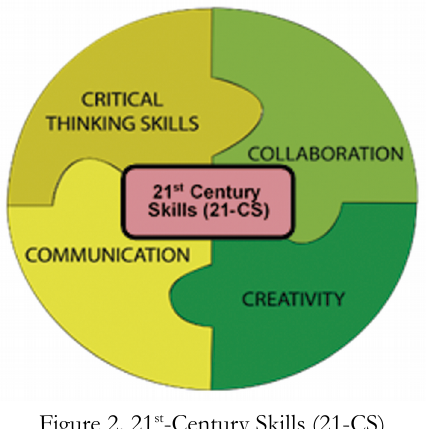
Figure 2. 21 st -Century Skills